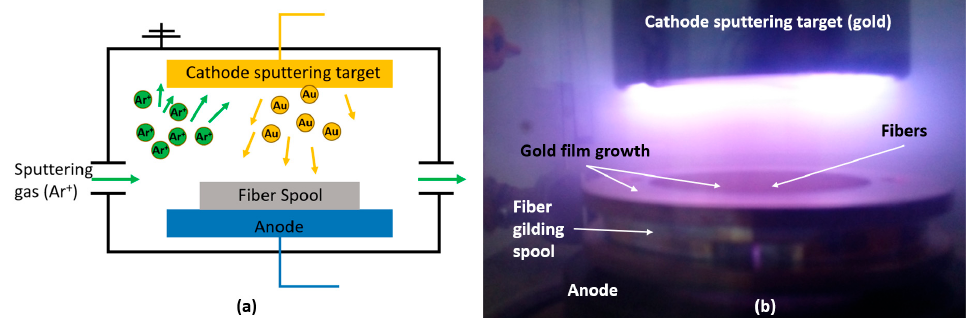
Figure 1. Fiber spool that is utilized for the gilding of the fiber segment via sputtering.